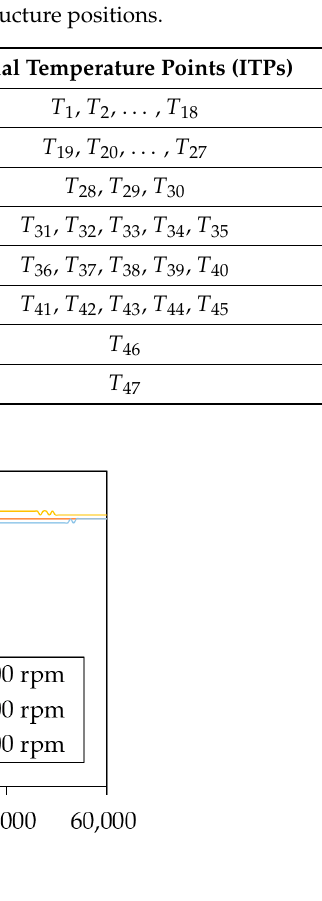
Figure 5. Spindle displacement in the z direction at different spindle rotation speeds.